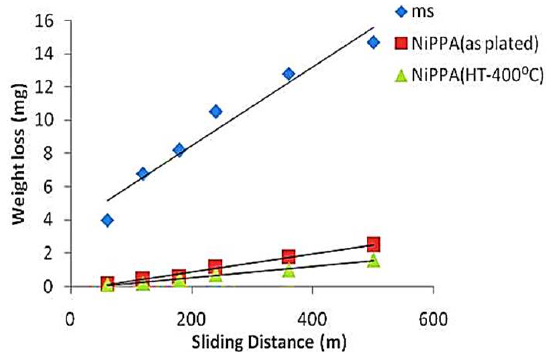
Figure 4. Wear loss of ms and NiPPA nano-dispersion coating at 30N load as plated and after 400 ◦ C temperature.